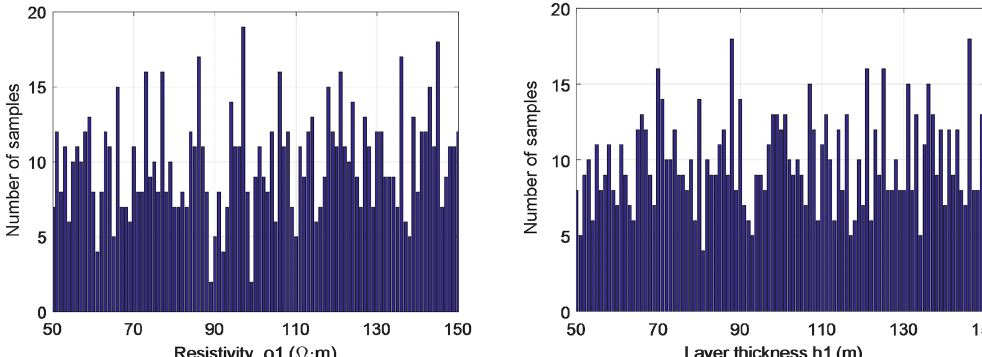
Figure 6. Distribution of resistivity ρ 1 and thickness h 1 in training